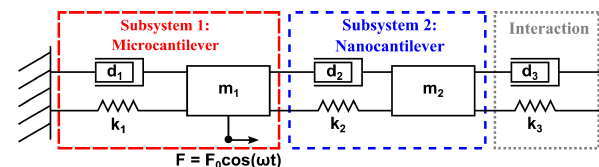
Figure 2. Mechanical model for the sensor depicted in Fig. 1.